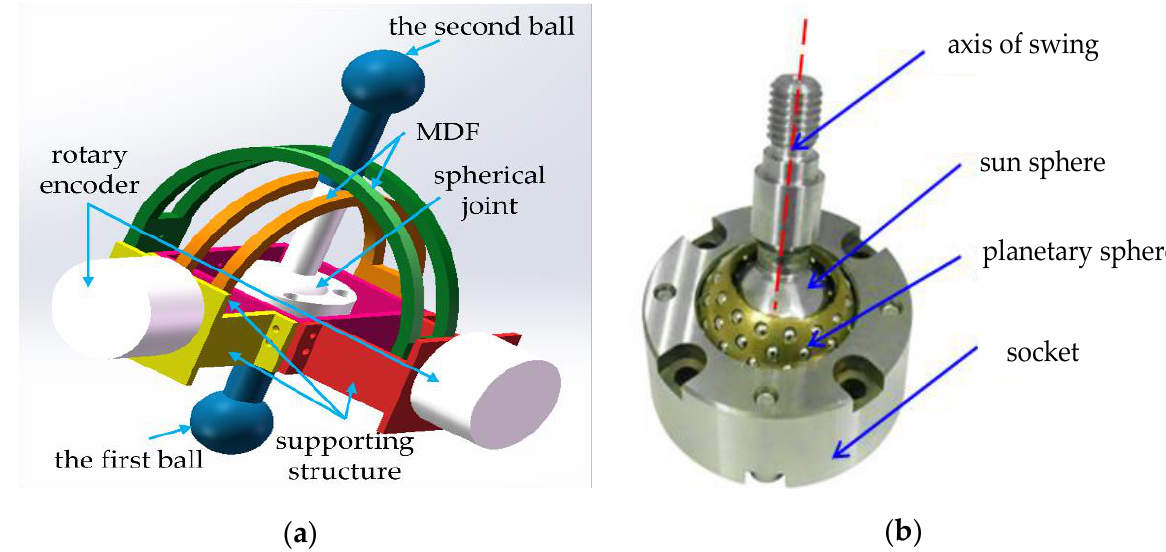
Figure 2. The angle measuring device of the spherical joint. ( a ) The angle measuring device. ( b ) The structure of spherical joint.